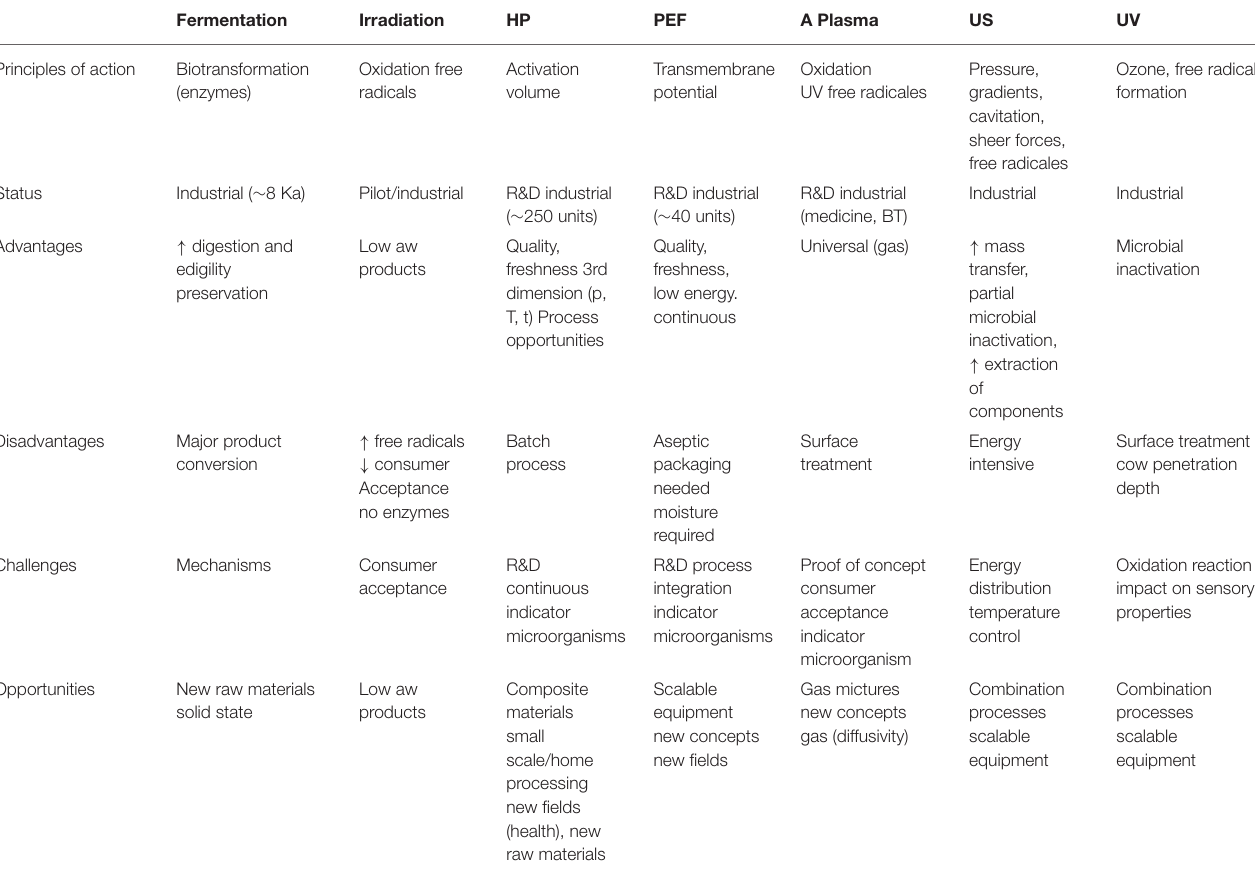
TABLE 1 | Comparison of common non-thermal processes including emerging